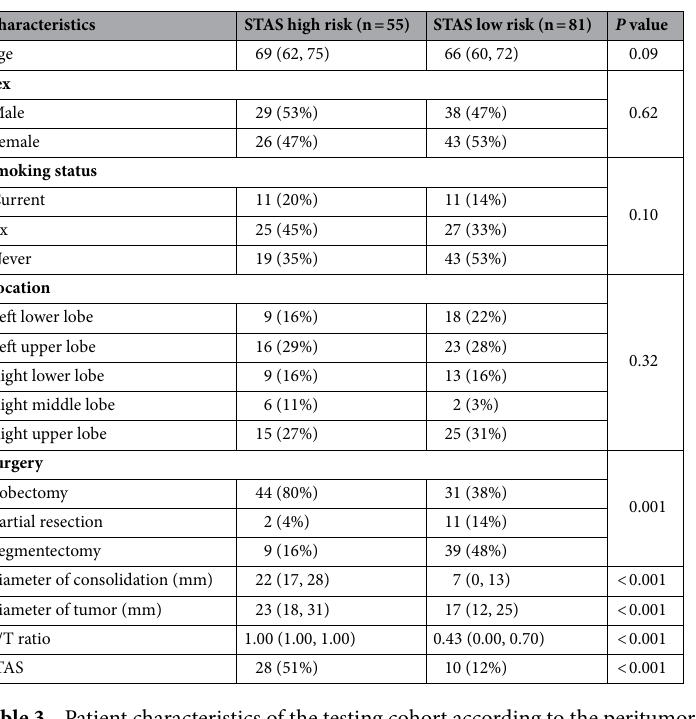
Table 3. Patient characteristics of the testing cohort according to the peritumoral radiomics risk model. Values are presented in median (interquartile range) or number (percentage). C/T ratio consolidation/tumor ratio, STAS spread through air spaces.